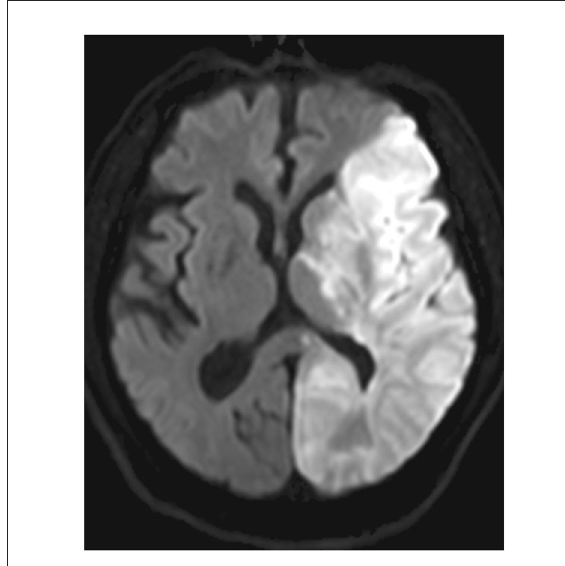
FIGURE2 Diffusion-weighted imaging demonstrating the topographical distribution of the left MCA stroke.